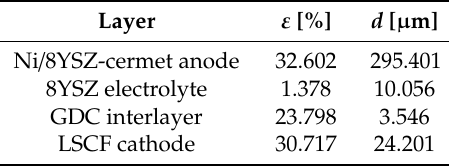
Table 2. Micro-structural